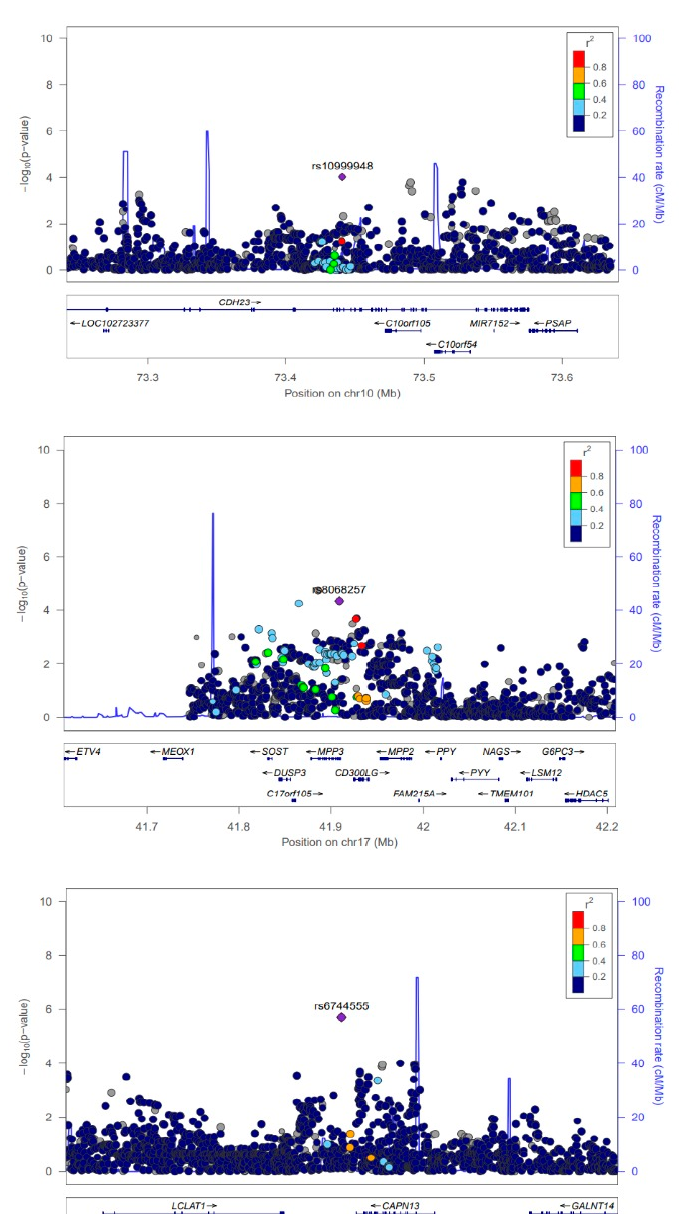
Figure 2. LocusZoom plot of the region around 10q22.2 (rs10999948), 17q21.31 (rs8068257), and 2p23.1 (rs6744555) among children from the SCAALA Cohort in Salvador, Brazil. The region includes genotyped and imputed variants from 1000 Genomes phase III. Pairwise r 2 values are from hg19/1000 Genomes European data (November 2014 release).